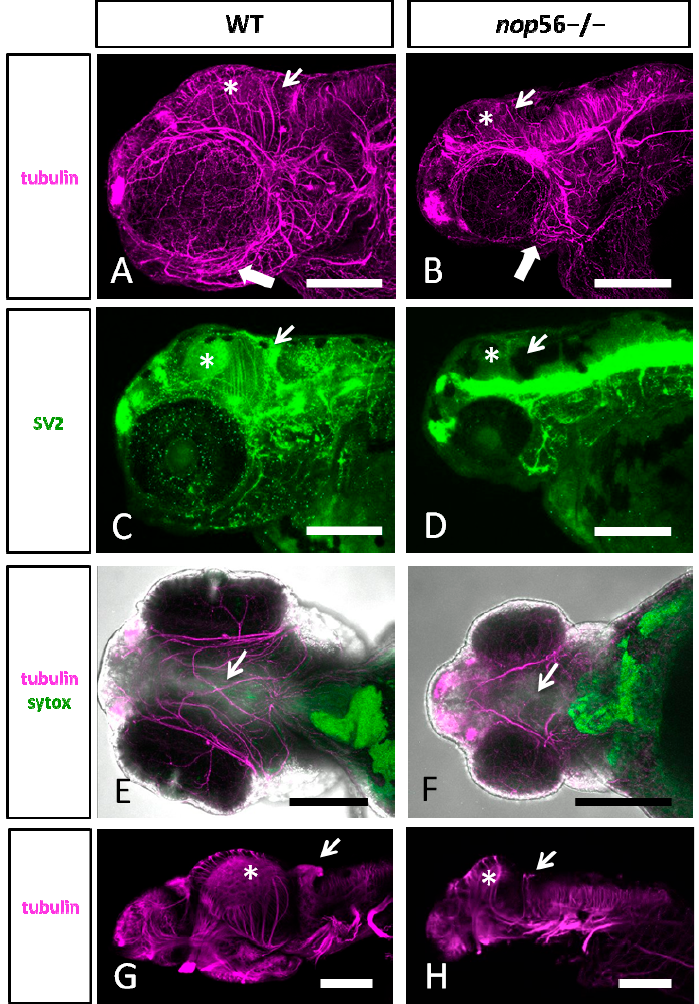
Figure 4. ( A , B ) Lateral views of WT (A) and nop56 − / − ( B ) 3.5 dpf larvae immunostained against α -tubulin (magenta) showing abnormalities in the jaw (thick arrow) and brain, specially in the midbrain (asterisk) and cerebellum (thin arrow). ( C , D ) Lateral views of WT ( C ) and nop56 − / − ( D ) fish immunostained against SV2 (green) showing different distribution in the brain, especially in the midbrain (asterisk) and cerebellum (arrow). ( E , F ) Ventral views of WT ( E ) and nop56 − / − ( F ) showing lack of midline fibers and bundles in the homozygous fish (arrow in ( F )), compared to WT (arrow in ( E )). ( G – F ) Lateral views of WT ( G ) and nop56 − / − ( H ) brain showing smaller midbrain in the ho- mozygous fish (asterisk in ( H )) and absence of labelling in cerebellum (arrow in ( H )), compared to WT (asterisk and arrows in ( G )). All images are projections from confocal z-stacks. Scale bars: 125 μ m.